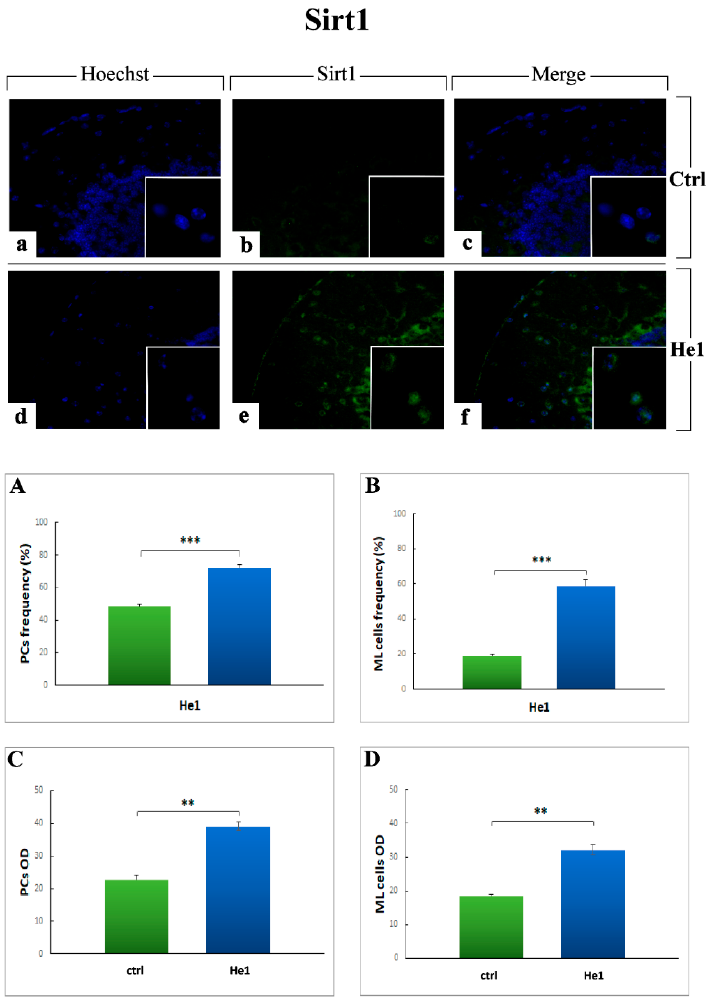
Figure 14. Immunofluorescence reaction for SIRT1 (green fluorescence) in untreated ( a – c ) and He1 mice ( d – f ). Nuclei were counterstained with Hoechst 33,258 (blue fluorescence). Objective magnification: 40× ( a – f ); 100× ( inserts ). Panels ( A – D ) Histograms showing quantitative analyses of SIRT1 immunopositive ML cell frequency and OD and immunoreactive PCs soma frequency and OD, re- spectively. p values calculated by unpaired Student’s t -test: ** p < 0.01, *** p < 0.001.